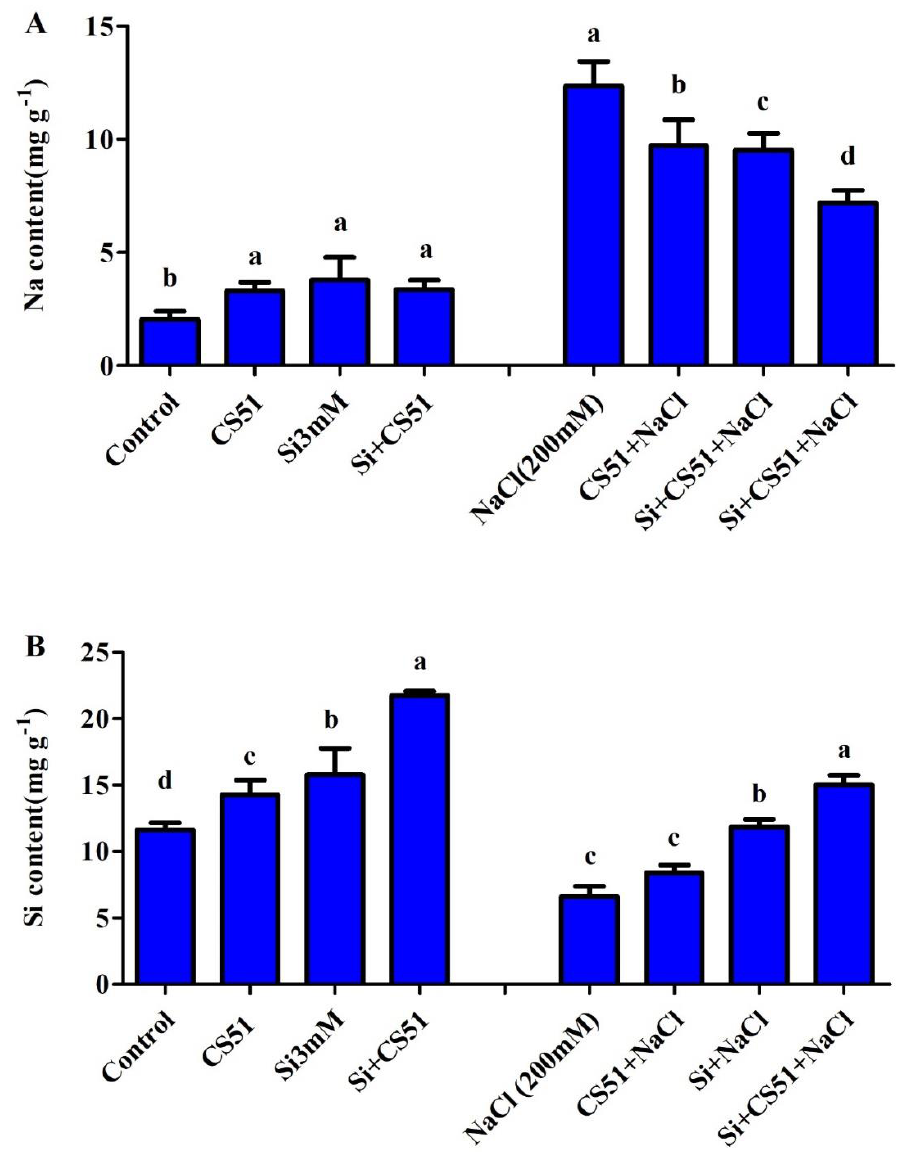
Figure 6. Inductively coupled plasma mass spectrometry (ICP) analysis of ( A ) Na + content and ( B ) Si content of maize grown in elevated NaCl (200 mM) treated with isolate CS51 and Si. Each value represents the mean ± SD of three replicates. Different letters on columns with error bars (mean ± SD) represent a significant difference among the treatments evaluated by Duncan’s Multiple Range Test (DMRT).